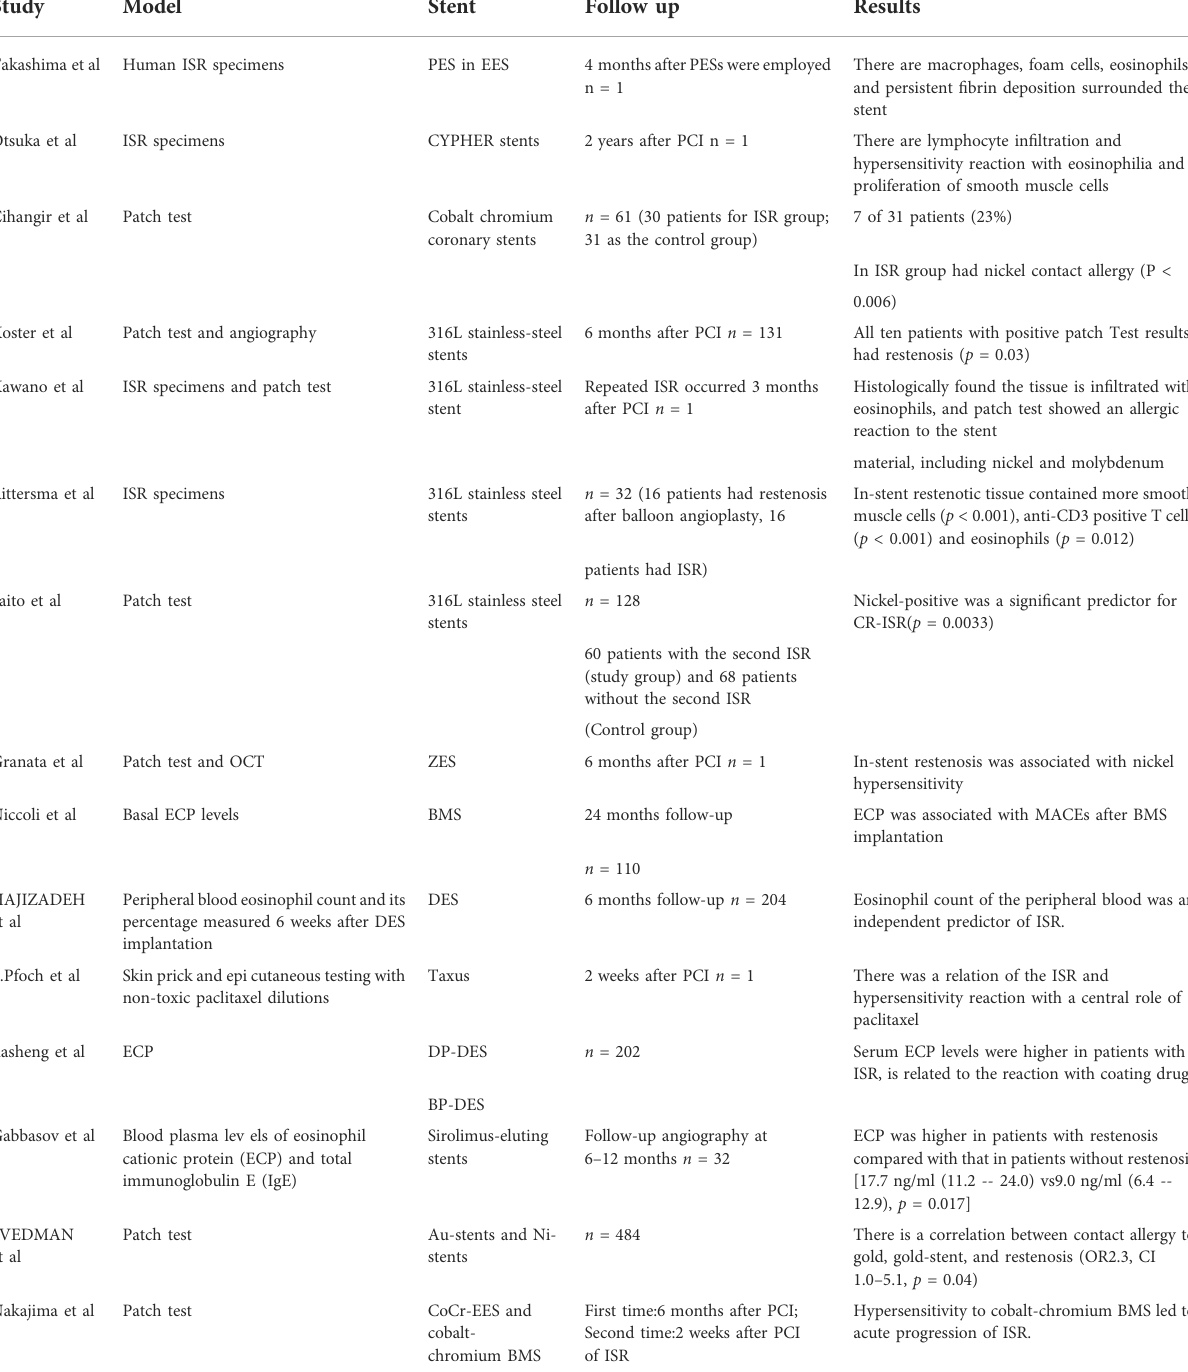
TABLE 1 Human studies and case reports implicating hypersensitivity in the process of